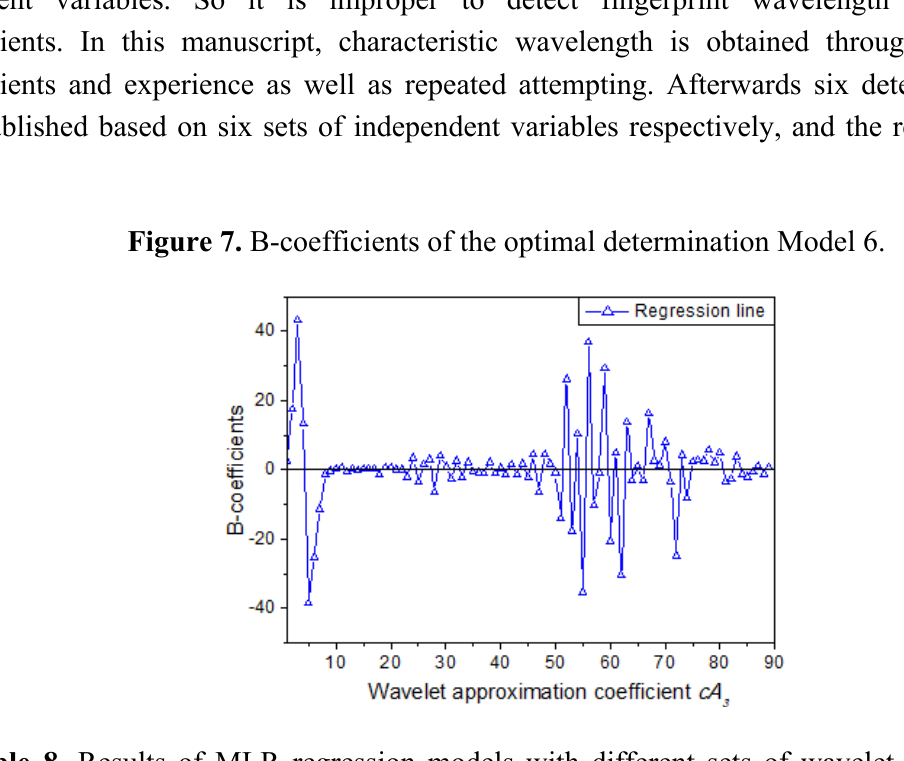
Table 8. Results of MLR regression models with different sets of wavelet approximate coefficients as independent